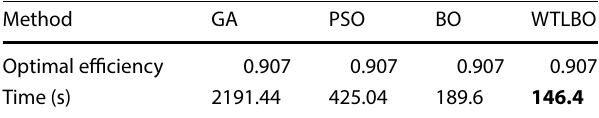
Table 3 Results of different methods on the target design task Method